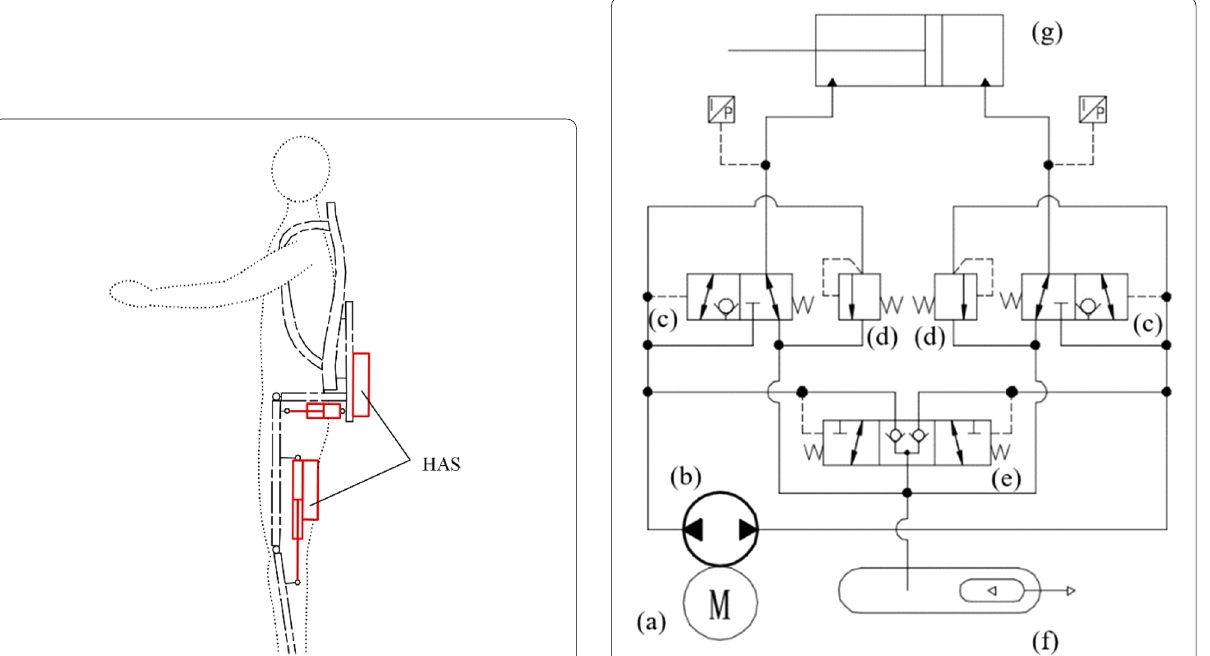
Figure 1 Schematic of the exoskeleton driven by four HASs Figure 2 Hydraulic schematic of the hip